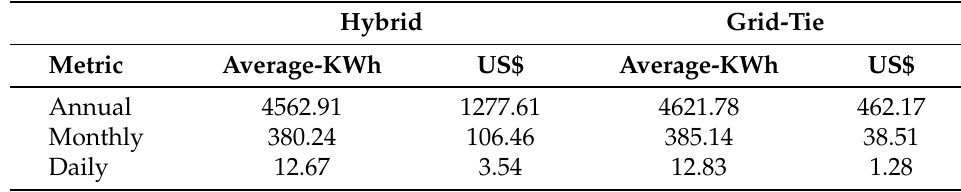
Figure 9. Equipment cost. Table 6. Energy produced/reduction